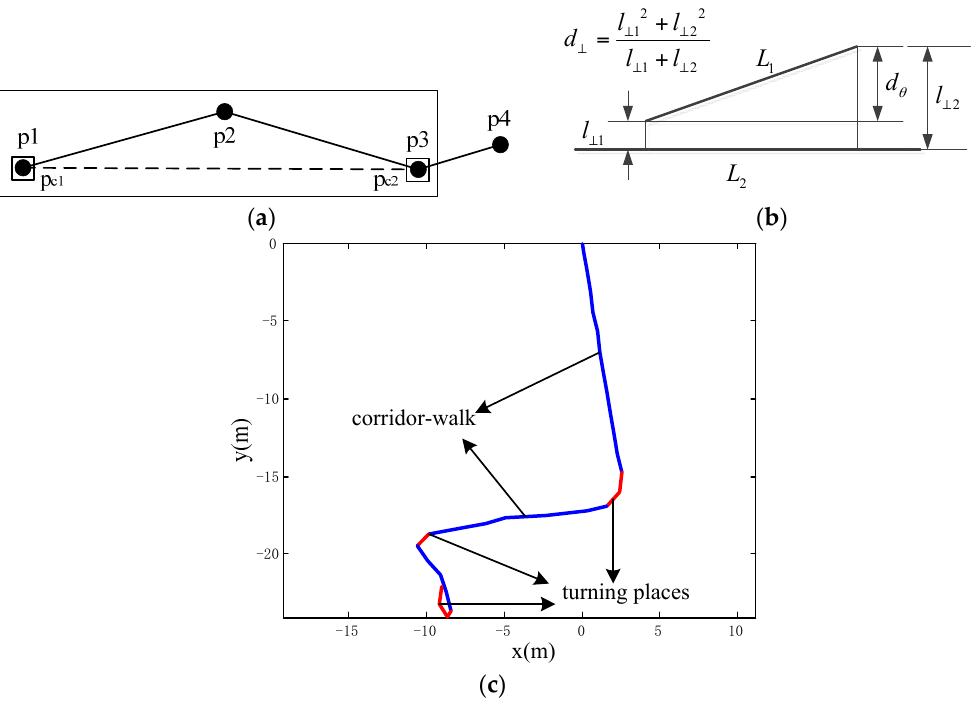
p and p are characteristic 1 c 2 c and angle distances d between two lines;  